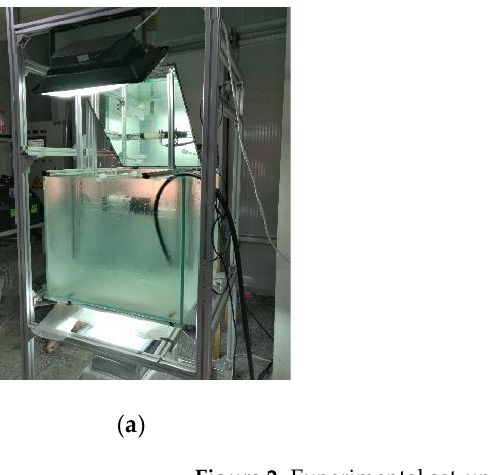
Figure 2. Experimental set-up. ( a ) real objects, ( b ) schematic view.